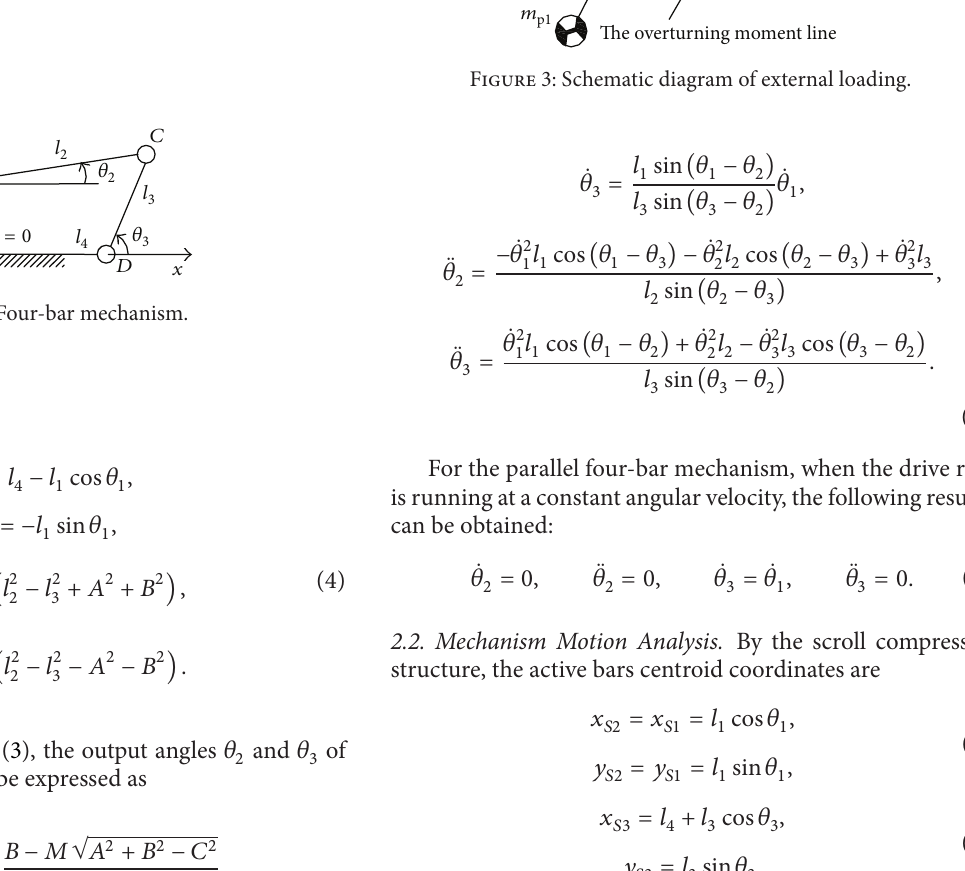
Figure 1: Configuration diagram of scroll compressor.